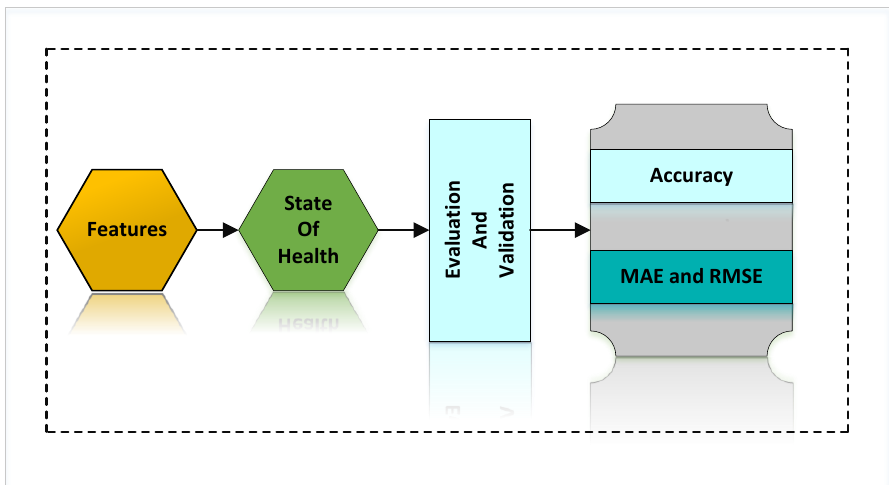
Figure 4. Process flow for evaluating the suggested